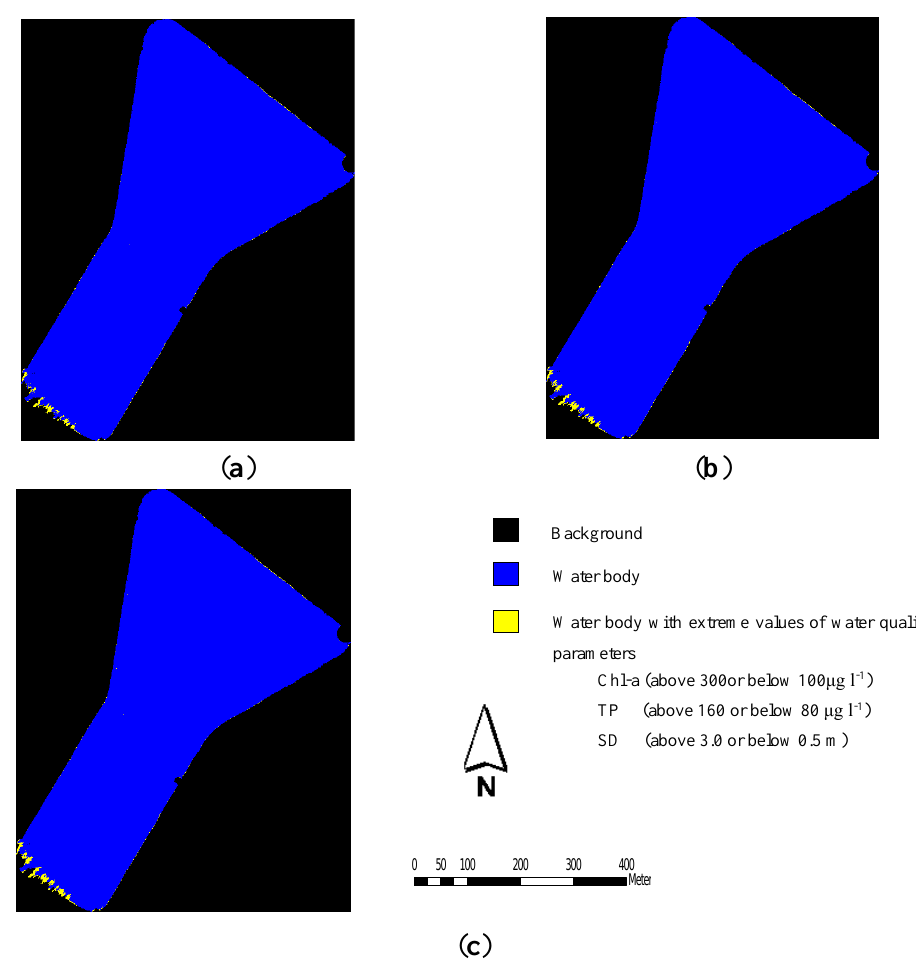
Figure 7. Mapping for extreme values of water quality parameters : ( a ) Chl-a , ( b ) TP , ( c )